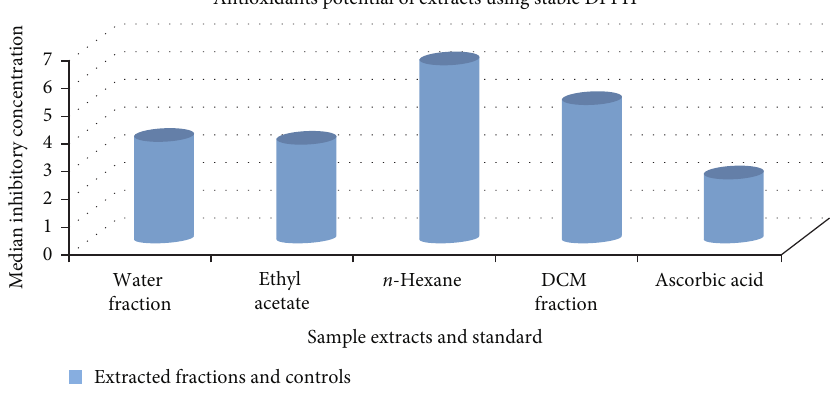
Figure 1: Comparisons of 50% inhibition of plant fractions and standard.